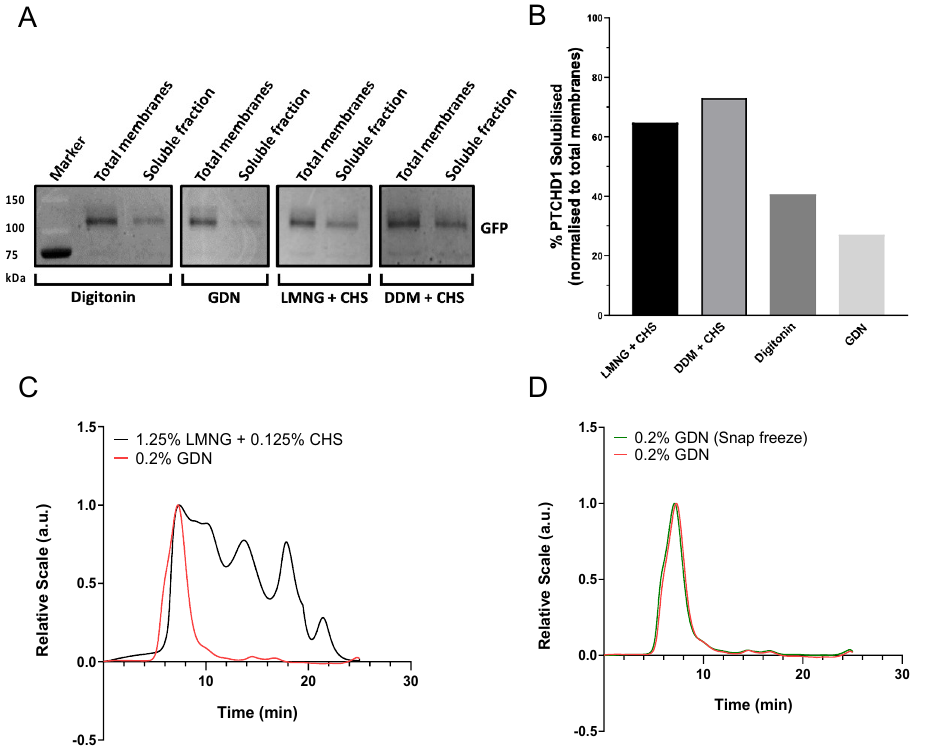
Figure 2. PTCHD1-GFP solubilisation and purification. ( A , B ) Small scale detergent screening indicates 1.25% DDM with 0.125% CHS solubilises PTCHD1-GFP from 2 g of membranes most efficiently (73%), closely followed by 1.25% LMNG with 0.125% CHS (65%). Solubilisation with 0.2% digitonin or GDN resulted in <40% solubilised PTCHD1. ( C ) SEC-MALS analysis of purified PTCHD1 from 13.5 g membranes solubilised in either 0.2% GDN or 1.25% LMNG + 0.125% CHS shows solubilisation in GDN results in a homogeneous sample, unlike solubilisation in LMNG. ( D ) The SEC-MALS trace of PTCHD1 purified in 0.2% GDN before and after snap freezing in liquid nitrogen.